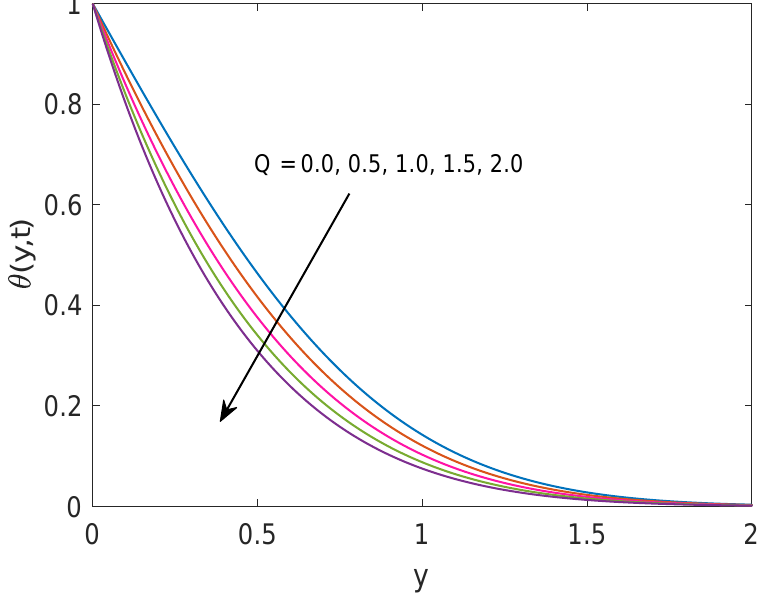
Figure 13. Temperature profile for different Q when Pr = 6.2, Nr = 1.5, φ = 0.1 and t =